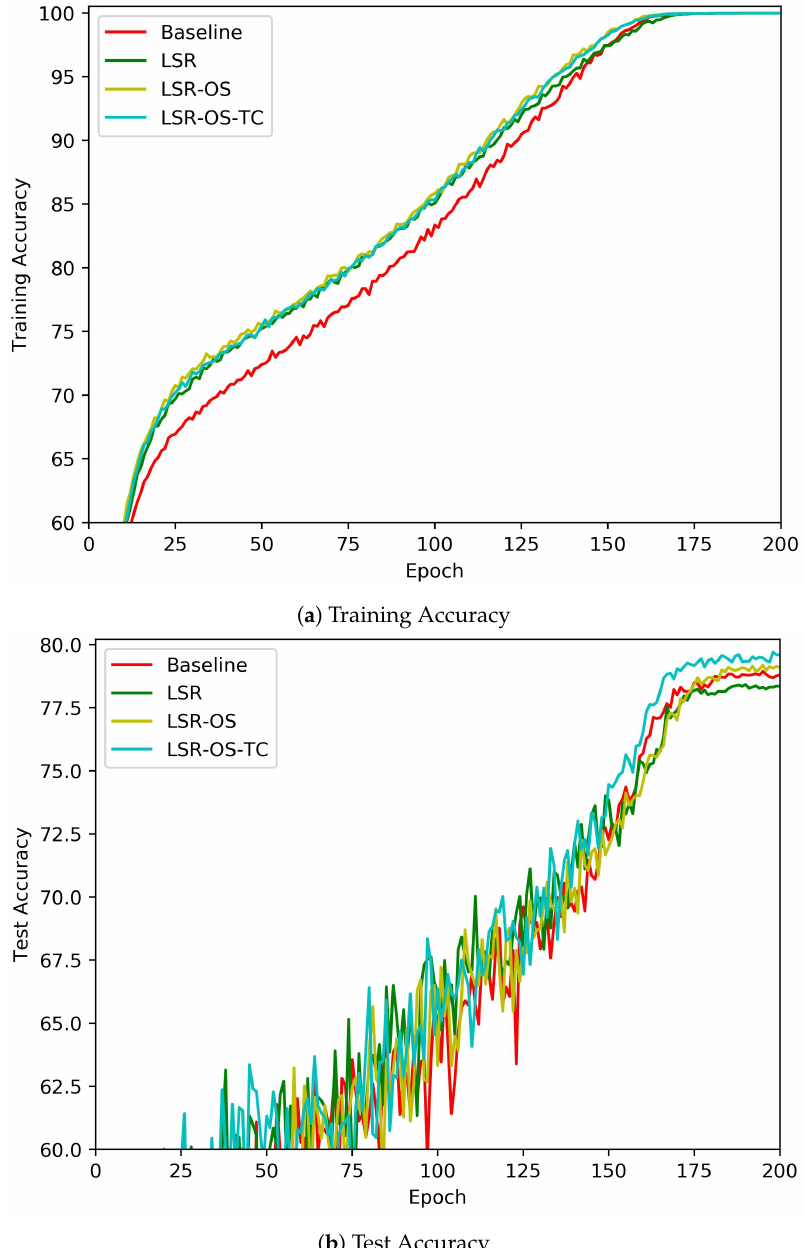
Figure 4. The accuracy curves for training on the CIRFAR100 dataset with the WRN-40-4